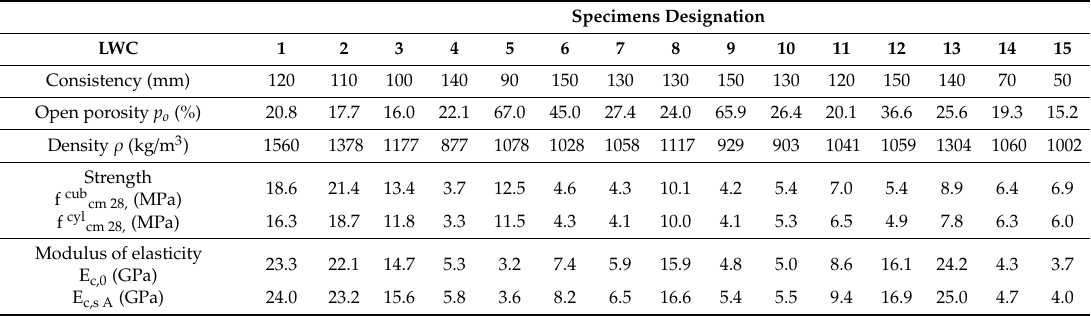
Table 7. Laboratory tests results for LWCs